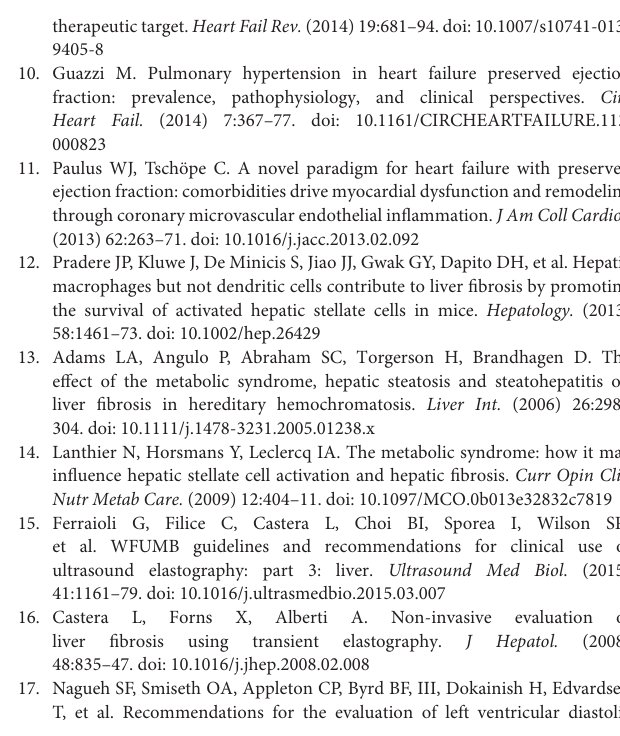
Supplementary Figure 1 | Scatter distribution of liver elastography values (LEV) and various laboratory indicators. (A) LEV and A/G; (B) LEV and Tbil; (C) LEV and Dbil; (D) LEV and Ibil; (E) LEV and ALP; (F) LEV and GGT; (G) LEV and lgNT-proBNP. Supplementary Figure 2 | Scatter distribution of liver elastography values (LEV) and various left ventricular parameters. (A) LEV and ventricular septal e ′ ; (B) LEV and lateral wall e ′ ; (C) LEV and average E/e ′ ; (D) LEV and LAVI; (E) LEV and TR peak flow rate; (F) LEV and LVMI (Male); (G) LEV and LVMI (Female). Supplementary Figure 3 | Scatter distribution of liver elastography values (LEV) and various right heart parameters. (A) LEV and right atrial diameter; (B) LEV and RVFAC; (C) LEV and TAPSE; (D) LEV and pulmonary systolic pressure; (E) LEV and TR peak flow rate. Supplementary Figure 4 | Detailed results of Kaplan-Meier analyses using Log-rank Test. Supplementary Figure 5 | Grading of liver fibrosis based on liver elastography value according to guidelines. Supplementary Table 1 | Comparison of LEV between HFrEF and HFpEF. Supplementary Table 2 | Comparison of clinical features among liver elastography value (LEV) quartiles. Supplementary Table 3 | Univariate and multivariate cox proportional hazard analysis of predicting MACEs in patients with